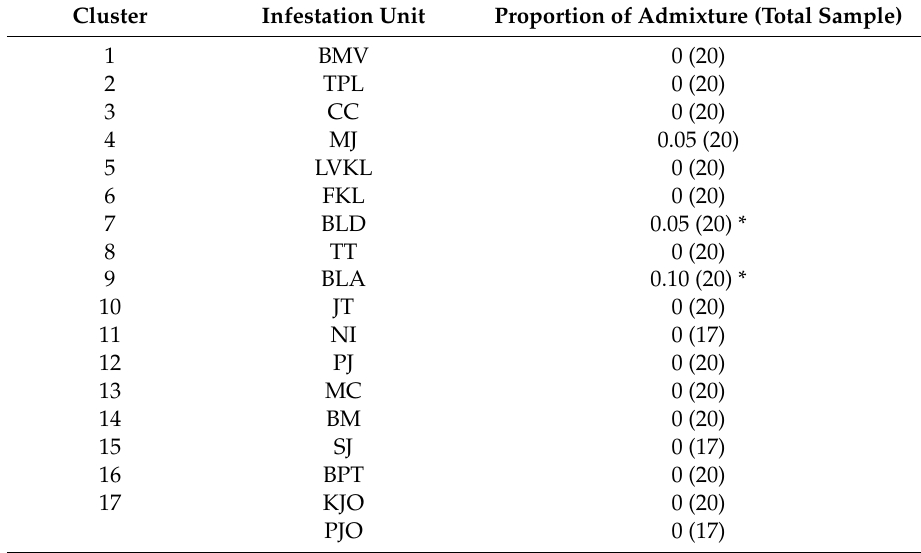
Table 5. Bayesian analysis of population structure (BAPS) analysis showing population clusters and the proportion of admixed individuals in each population.